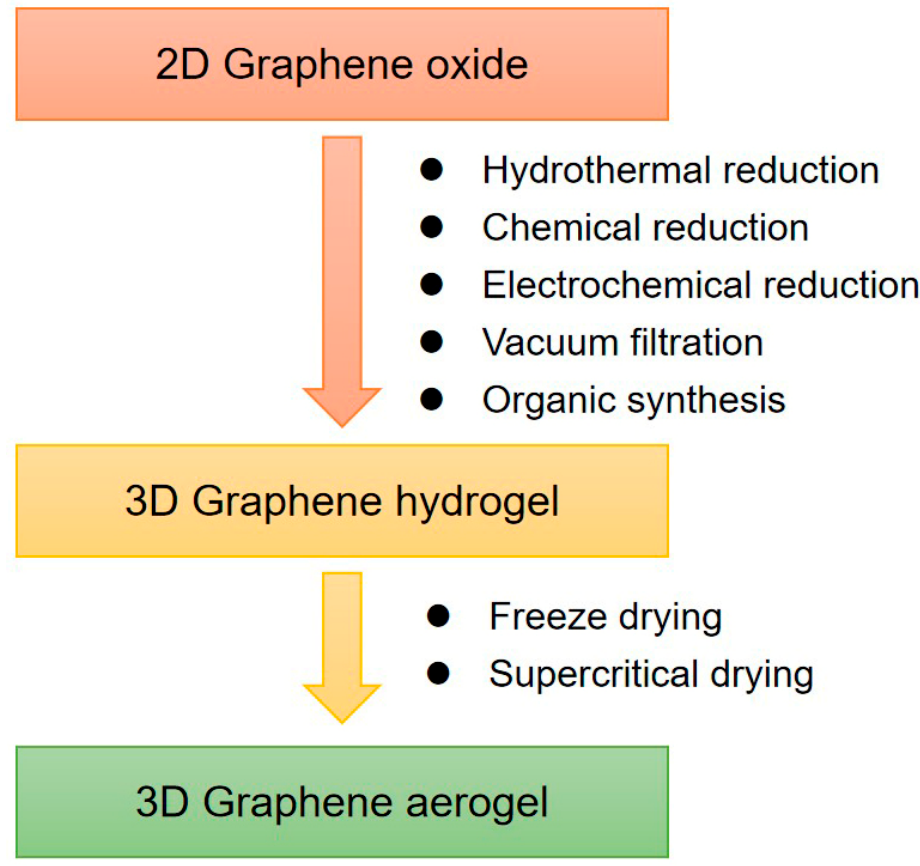
Figure 1. Synthesis methods of 3D graphene frameworks.